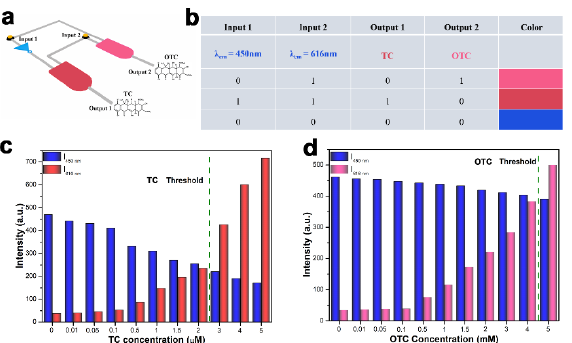
Figure 8. ( a ) Logic circuit based on the corresponding symbols, ( b ) the resulting truth table from different input modes and column diagram of the thresholds for detecting TC ( c ) and OTC ( d